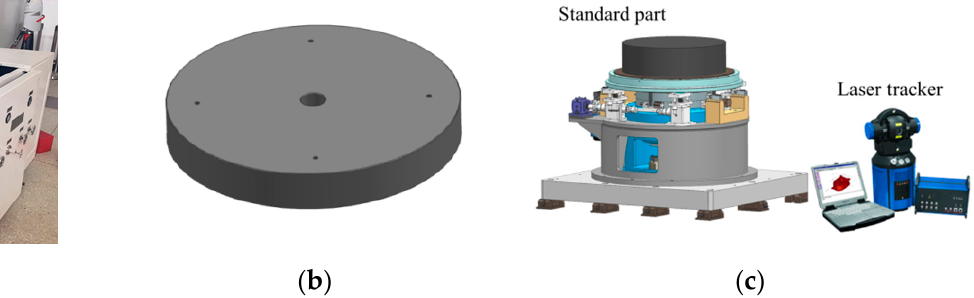
Figure 6. ( a ) Physical picture of the measurement system; ( b ) 3D model of standard parts; ( c ) standard sample mass centroid measurement diagram.